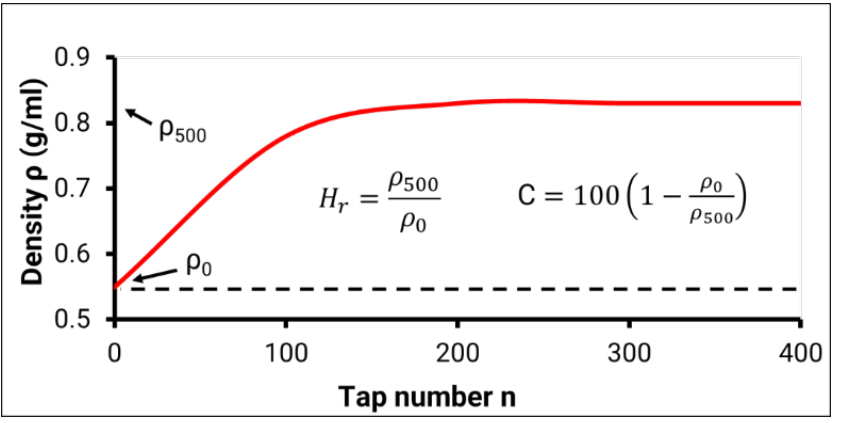
Figure 1. Example of compaction curve obtained by GranuPack—illustrating bulk density ( ρ 0 ), tap density ( ρ 500 ), Hausner ratio ( H r ), and Carr index ( C ) .